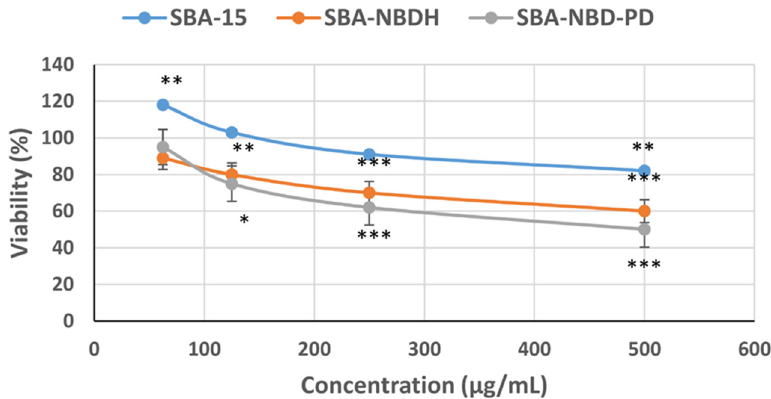
Figure 15. Cytotoxic, antiproliferative effects of SBA-15, SBA-NBDH, and SBA-NBD-PD on B16- spheroids. Spheroids were obtained after seeding 10,000 cells/well and allowed to grow for 3 days and then treated 5 days with different concentrations of silica compounds. Data are presented as mean ± SEM.* 0.01 < p < 0.05, ** 0.001 < p < 0.01, *** p < 0.001.